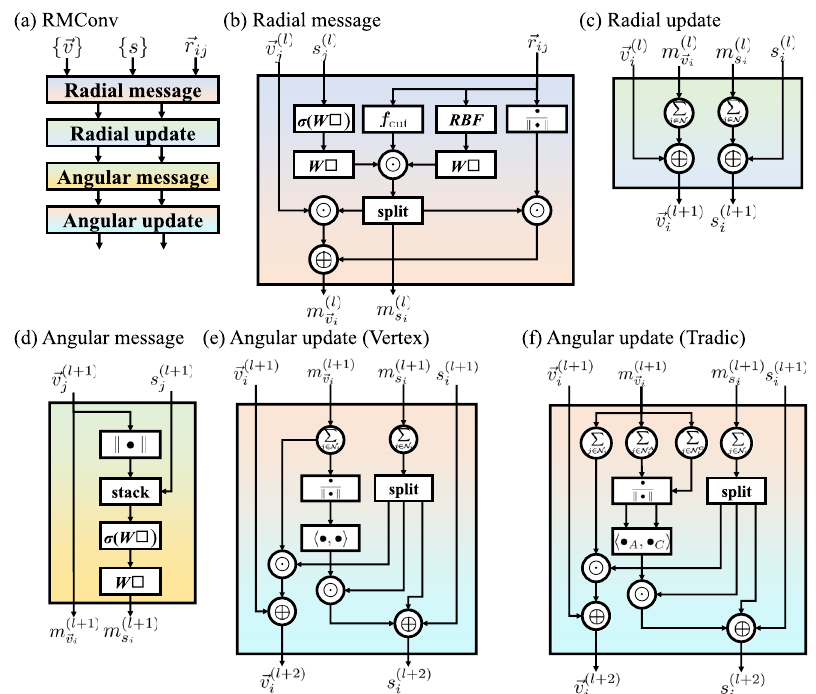
Fig. 3 The overview of the sub-networks in HVNet and HTNet. a is the architecture of the sub-network, termed relational message passing convolutional (RMConv) layer. Such a RMConv layer is a simpli fi ed and modi fi ed PAINN 22 invoked for a speci fi c type of interaction, and is constituted by ( b ) radial message layer, c radial update layer, d angular message layer, and e or f angular update layer. { s } is the set of scalar node features and initially set as the atomic numbers, which will be passed through an embedding layer. Initial vectorial node feature v k r ! k an all-zero vector with a fi xed dimension. sin n π ij r cut